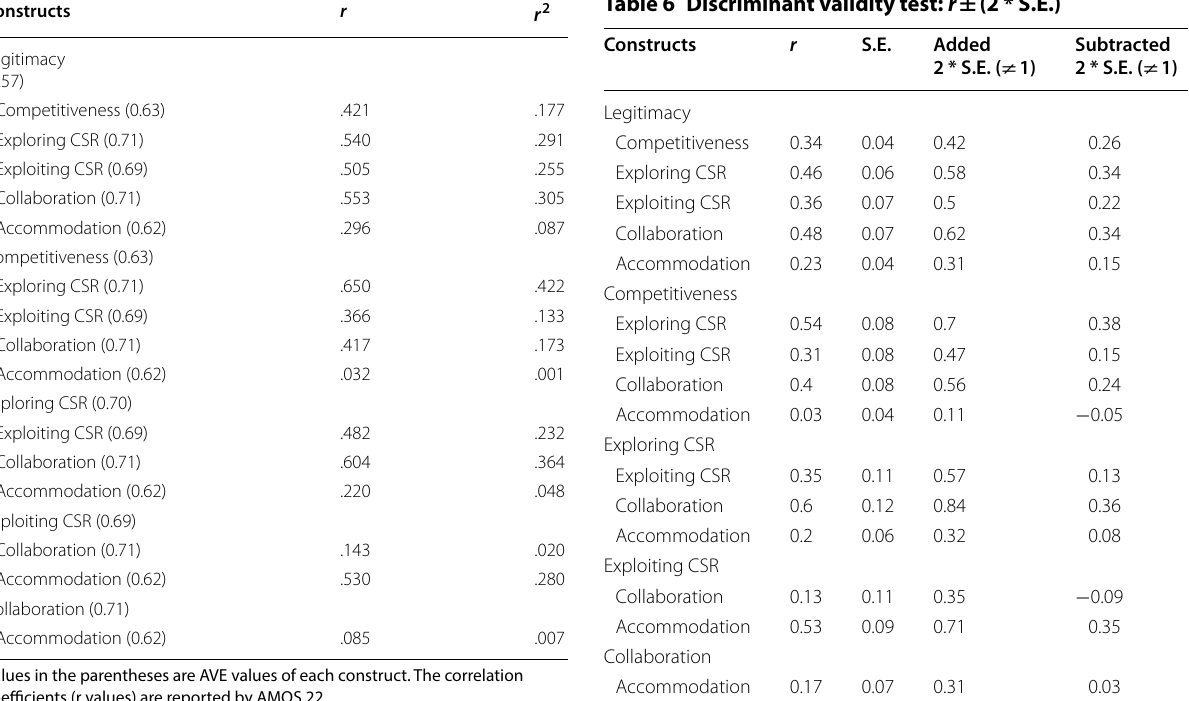
Table 5 Discriminant validity test: aVE, r and r 2